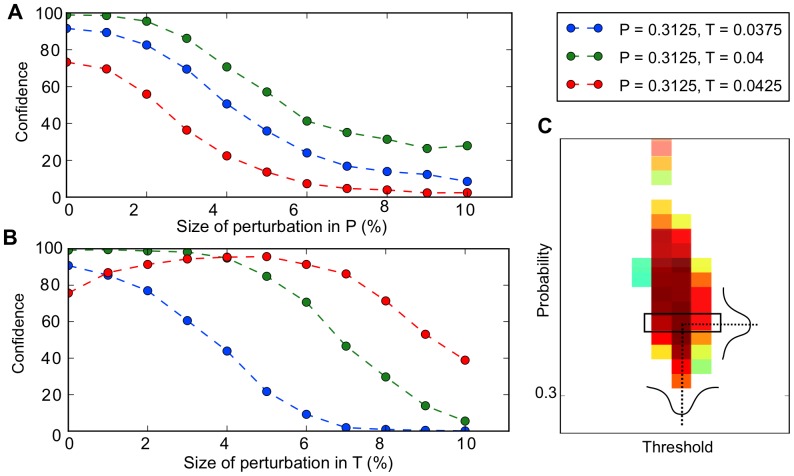
Special values of  exhibit robustness against perturbations in  and .(A) Perturbations in  show that parameters with higher initial confidence also exhibit robustness to larger perturbations in . (B) Perturbations in  can produce critical behavior where a parameter combination with an initially low confidence can benefit from added noise to the value of . (C) This shows the region in parameter space from which the three parameter combinations were chosen (black box). The colors indicate the initial confidence at that point before perturbation.